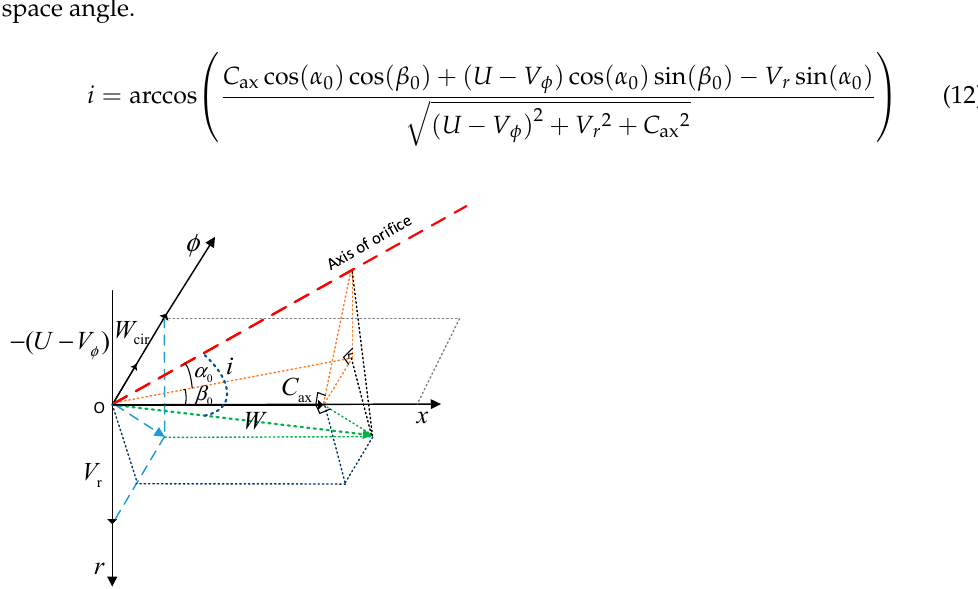
Figure 2. Velocity triangles at the orifice with complex inlet flow conditions.